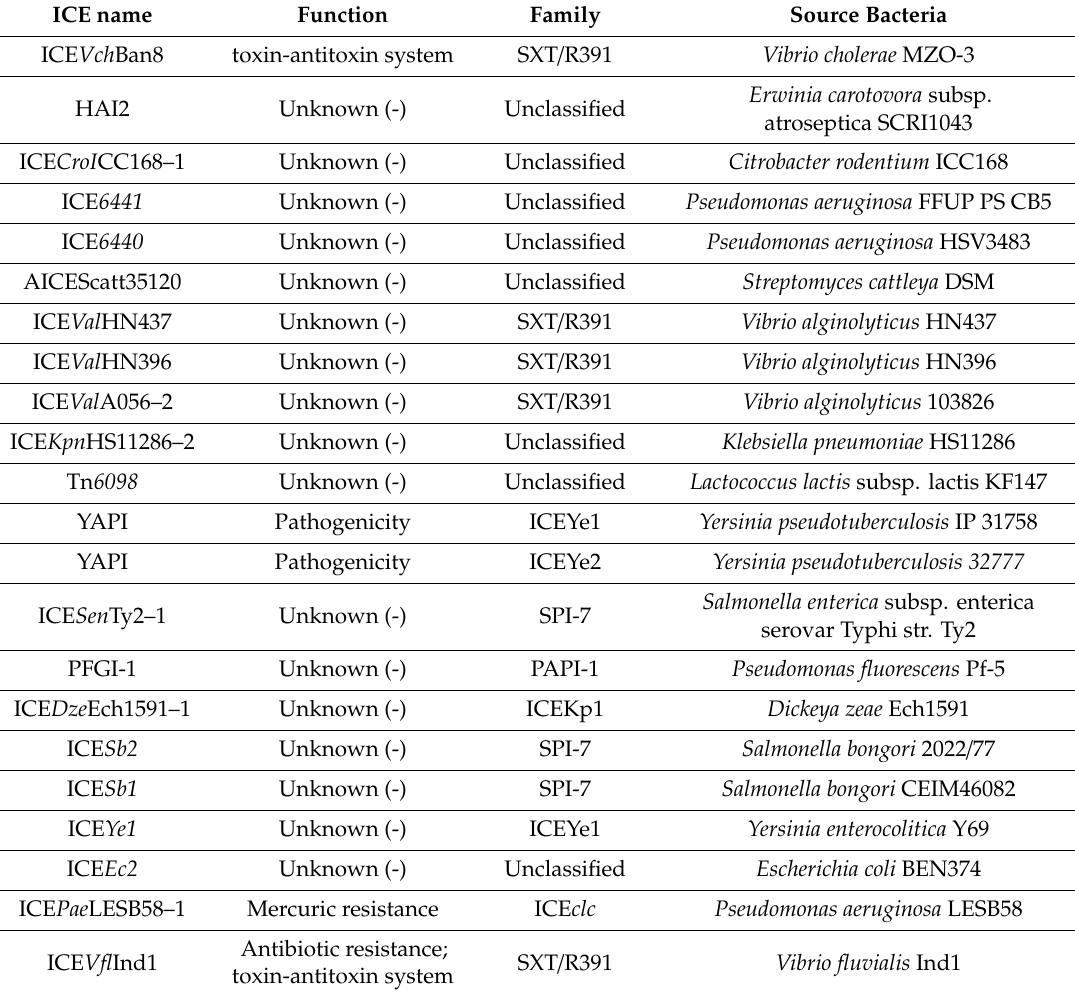
Table 2. Integrative conjugative elements ubiquitously identified in E. coli genomes along a One Health